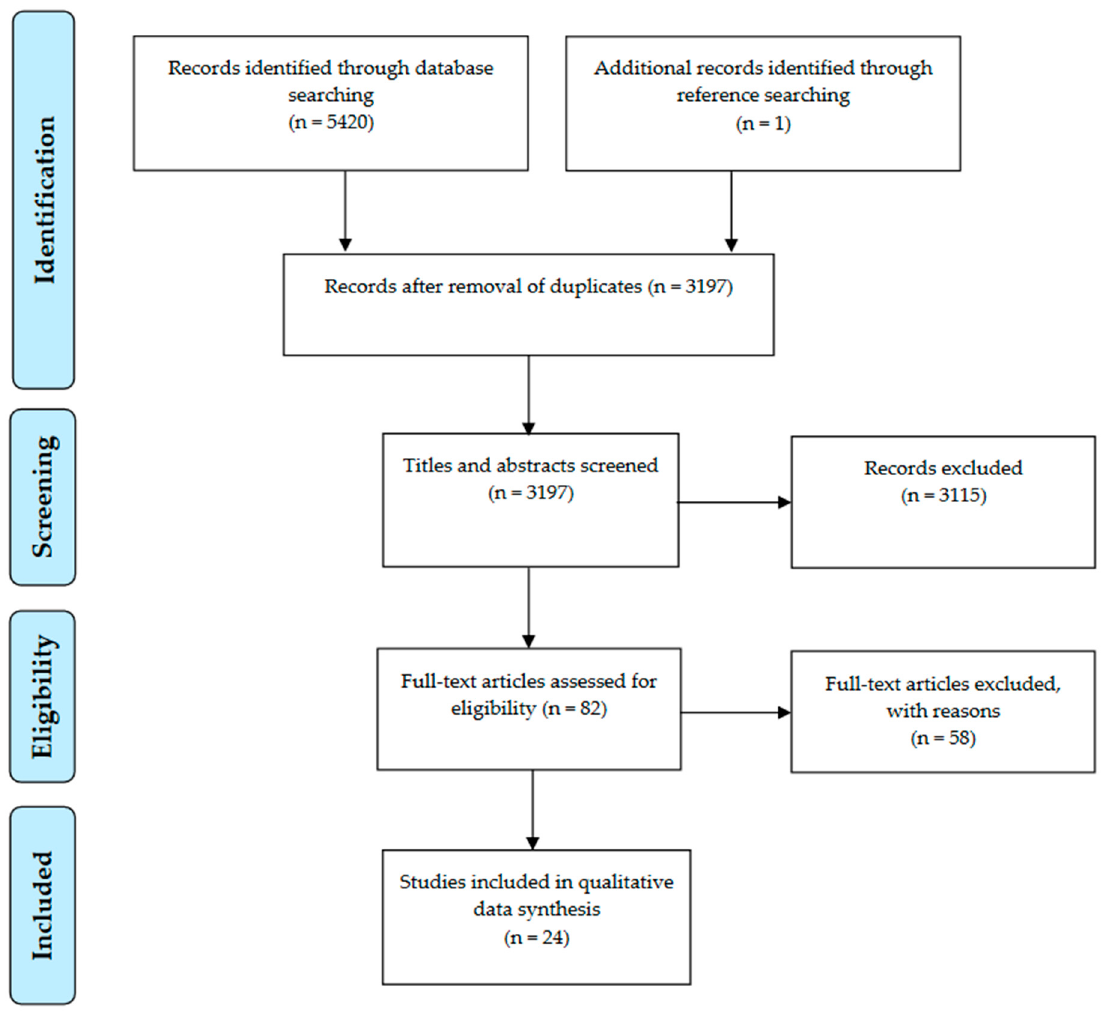
Figure 1. Flow of studies through the review.